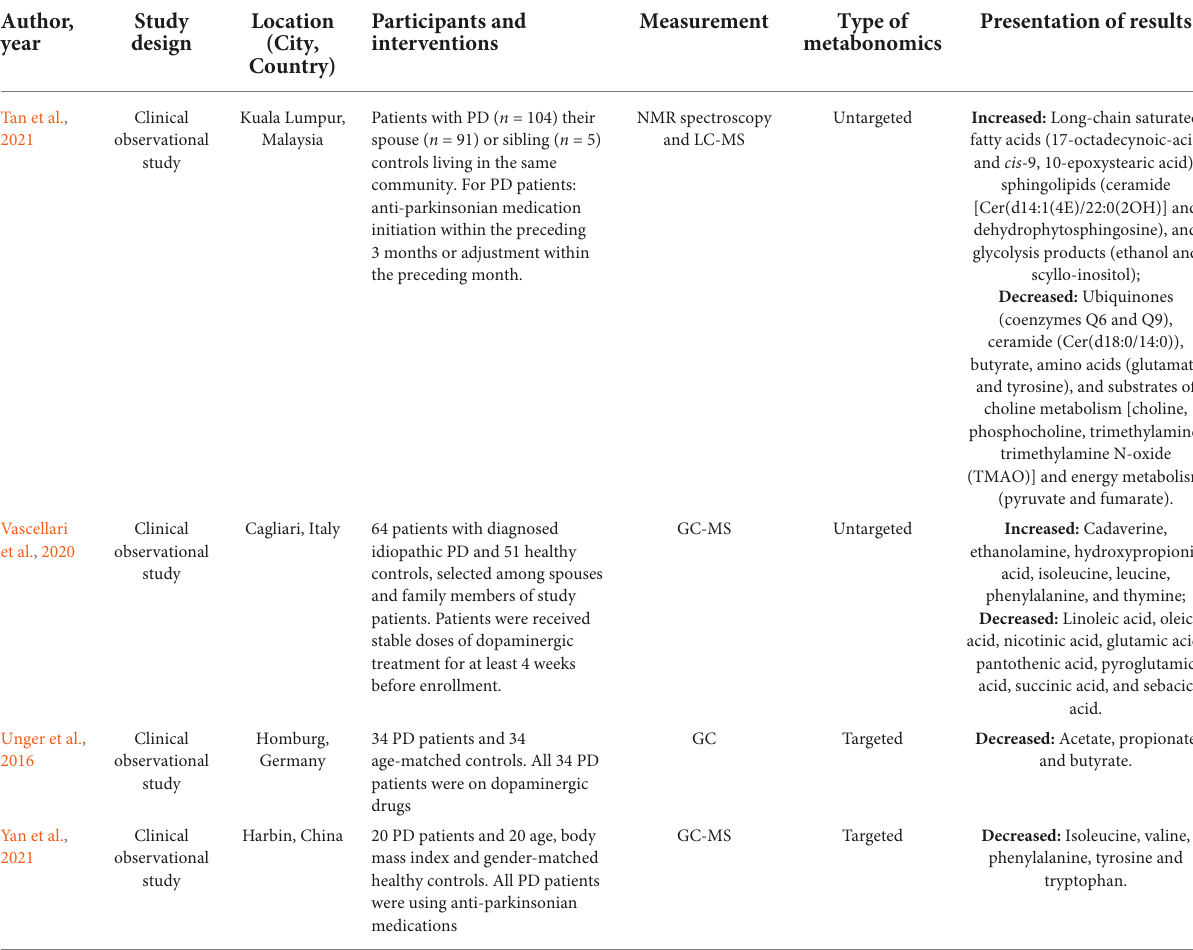
TABLE 1 Characteristics of eligible